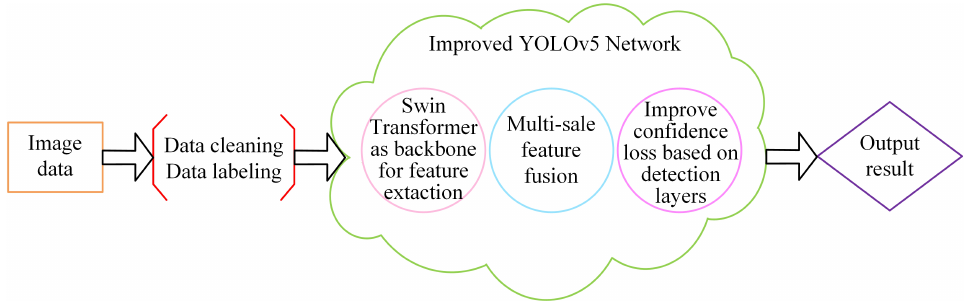
Figure 3. The improved YOLOv5 is used for underwater target